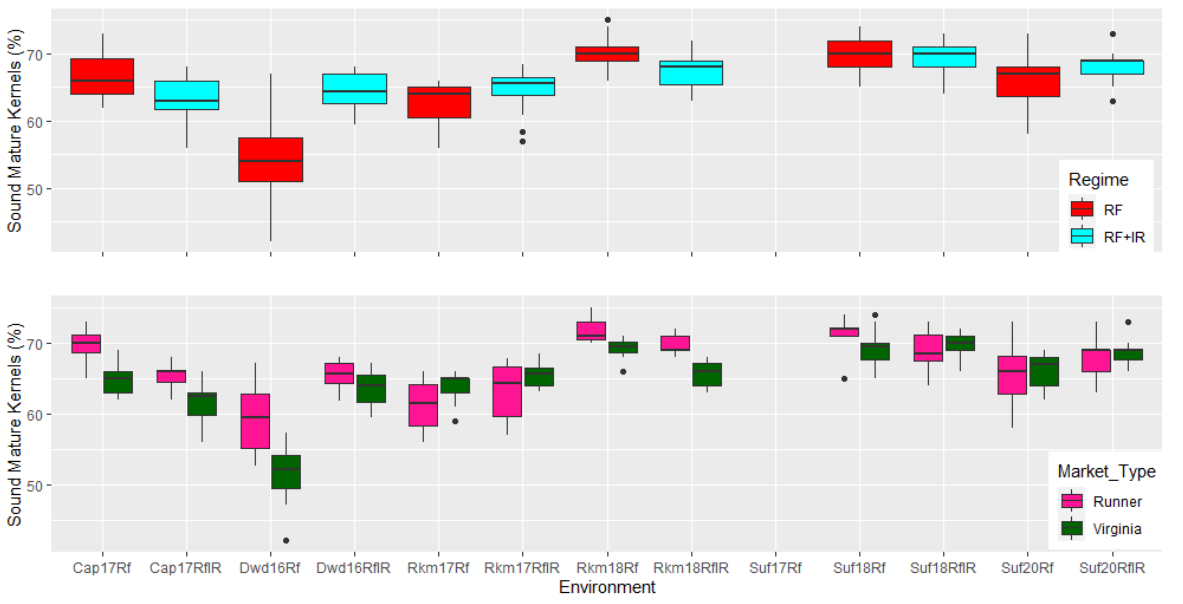
Figure 4. Boxplot for the effect of water regime and market type on sound mature kernels (SMK) of 5 Virginia and runner peanut cultivars in 13 environments. Each plot indicates total range, interquartile range (box), and median (line). Environment names are coded and the first three letters indicate location; Cap, Capron, VA; Dwd, Dinwiddie, VA; RM, Rocky Mount, NC; Suf, Suffolk, VA; two digits indicate year of the trial; 16 for 2016, 17 for 2017, 18 for 2018, 20 for 2020; and the last letters Rf and RfIR for water regime: Rf, rainfed, RfIR, rainfed plus irrigated. The upper part of the figure shows the effect of water regime and the lower part the effect of market type on the sound mature kernels content.